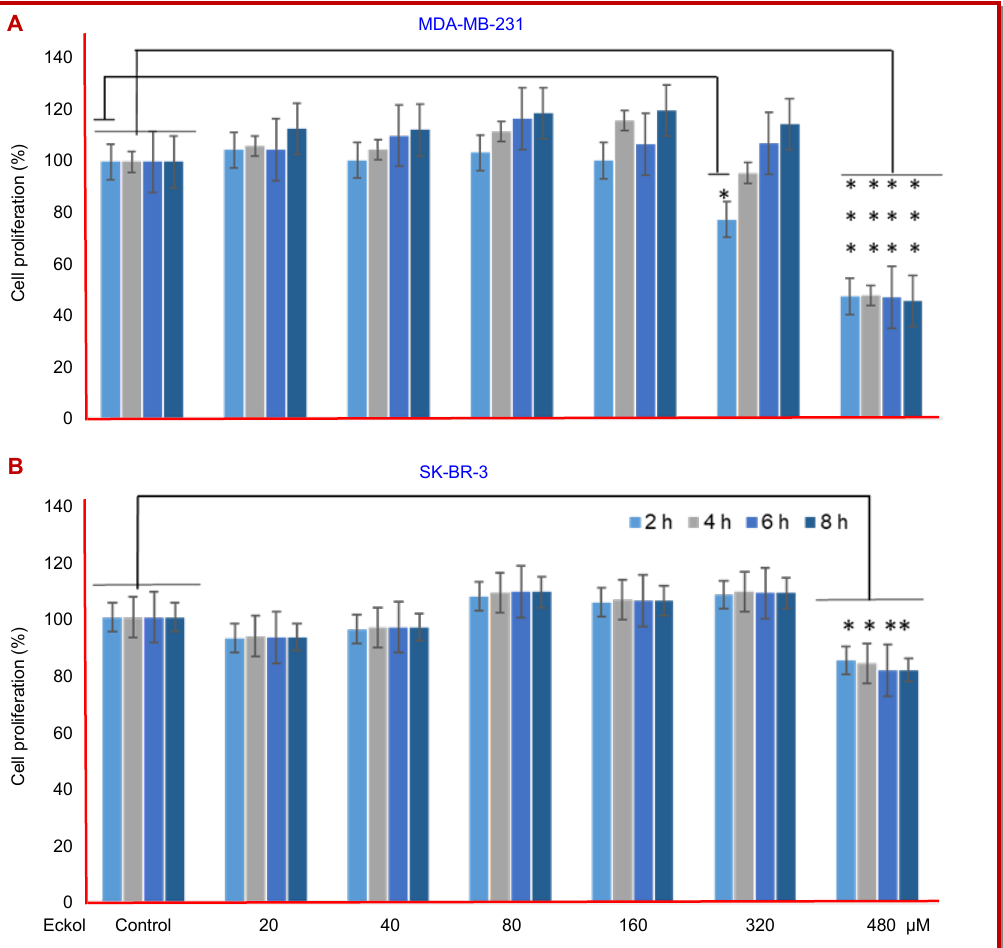
Figure 3: Effect of eckol on the proliferation of MDA-MB-231 and SK-BR-3 cells. MDA-MB-231 cells proliferation analysis, cells exposed control – different concentrations of eckol for 2, 4, 6 and 8 hours (A). B) SK-BR-3 cells treated with control- different con- centrations of eckol for 2, 4, 6 and 8 hours (B). a indicates p<0.05, b p<0.01, c